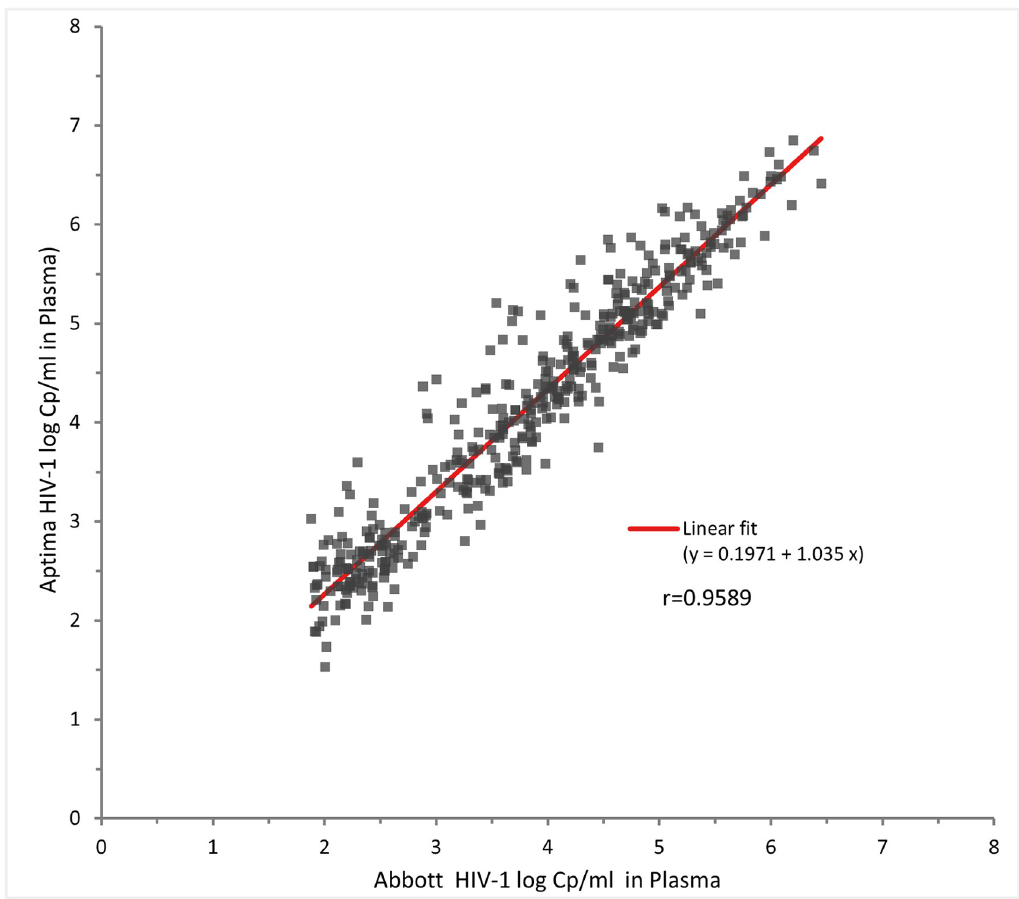
Fig 1. HIV VL comparison for 436 plasma samples tested in Aptima and Abbott RT